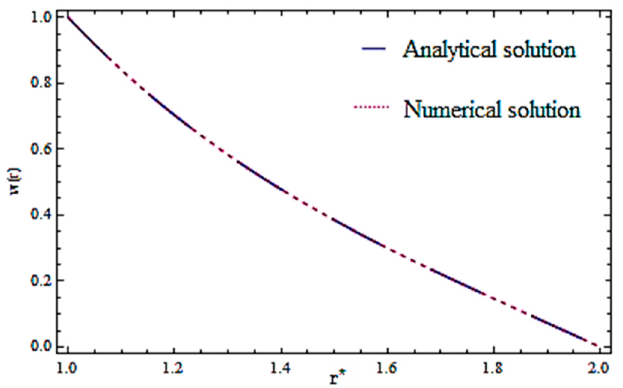
= 5, ε D 2 = 10, X = 0.5, X = 1 1 2 1